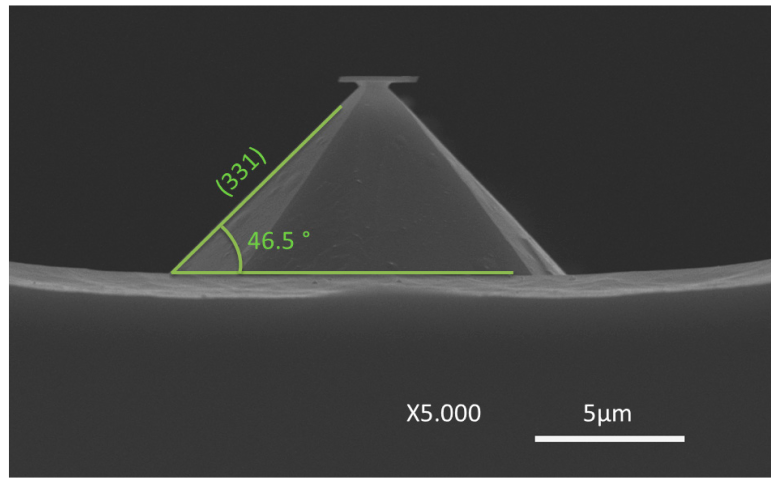
Figure 8. SEM cross-section image of the structure obtained with a 10 μm × 10 μm square mask, spaced 20 μm from the next square, in a 22 wt % KOH wet etch process (Sample 2 in Table 1). IPA availability takes an important role defining the etched structure in top view SEM images. Near the optimal volume of IPA, the influence on the number of etched planes is maximized.